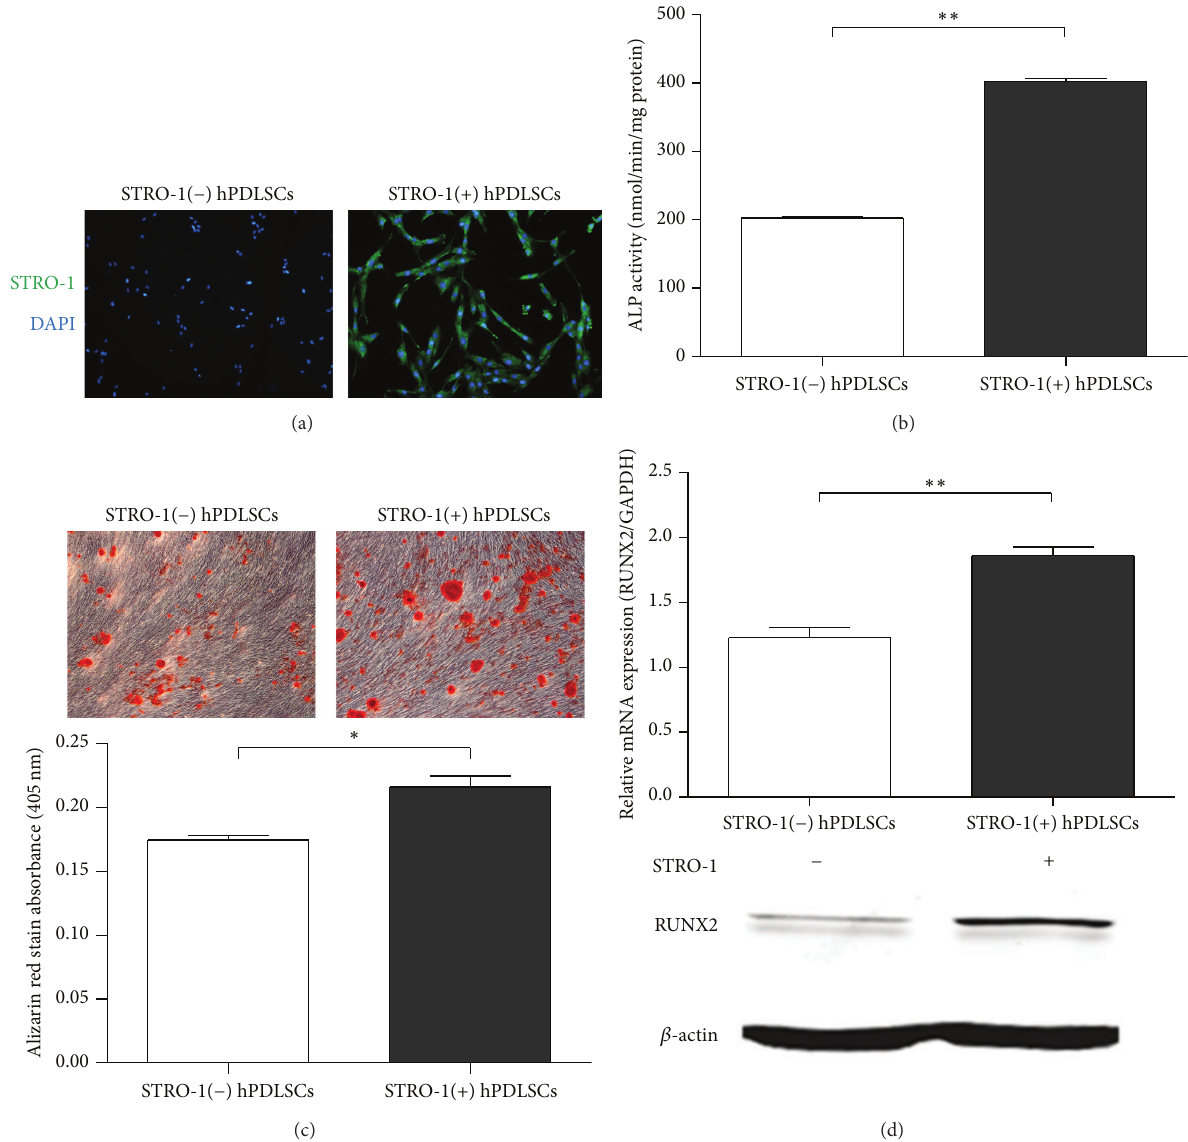
Figure 2: STRO-1(+) hPDLSCs exhibited strong osteogenic capacity. (a) Immunostaining for Stro-1 in isolated STRO-1(+) and STRO-1( − ) hPDLSCs (magnification: 50x). The surface marker Stro-1 was stained with FITC and visualized using fluorescence microscopy. Nuclei were stained with DAPI (blue). (b) ALP activity in STRO-1(+) and STRO-1( − ) hPDLSCs. (c) Osteogenic differentiated cells were stained with Alizarin red (magnification: 100x). (d) Real-time PCR and western blot analyses of Runx2 expression in STRO-1(+) and STRO-1( − ) hPDLSCs. The expression of each target was normalized to that of GAPDH. Data are presented as the means ± SDs of three independent experiments performed in duplicate. ∗ 𝑃 < 0.05 , ∗∗ 𝑃 < 0.01